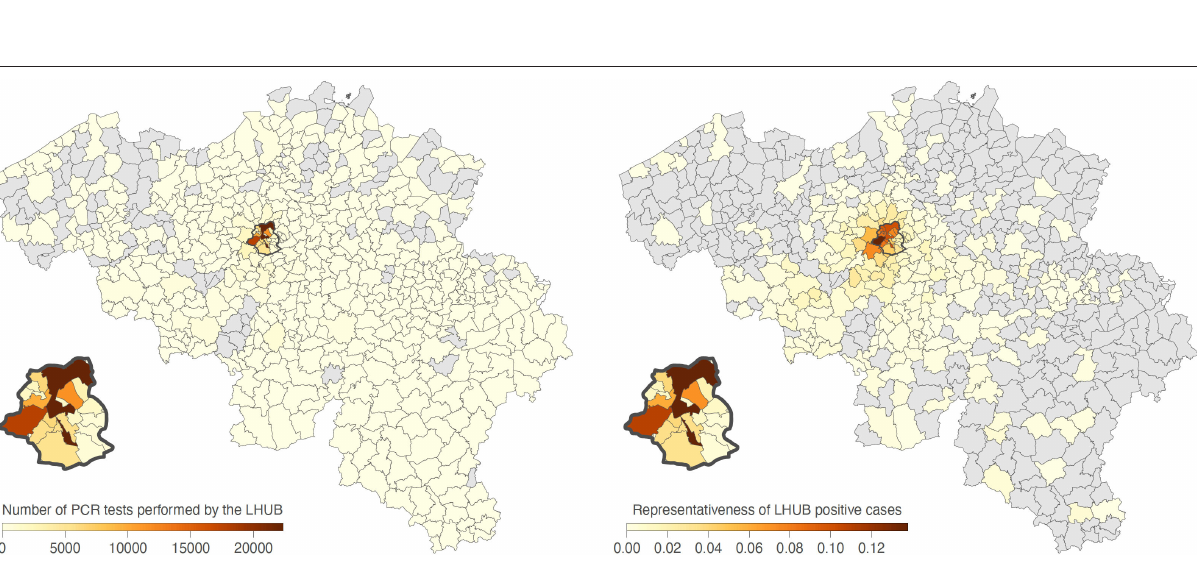
FIGURE 2 | Mapping by municipality of SARS-CoV-2 RT-PCR tests performed by the LHUB-ULB since March 8, 2020, and of the proportion of positive cases detected by the LHUB-ULB compared to the overall number of positive cases detected in those areas. The Brussels Region is highlighted by a dark grey contour and